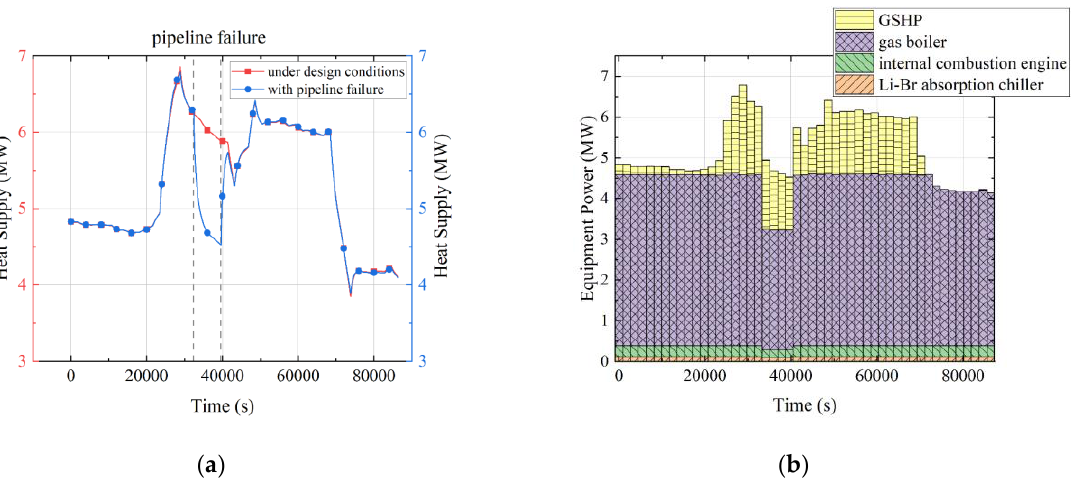
Figure 11. Dynamic response of IES during pipeline failure period. ( a ) heat supply; ( b ) equipment power.